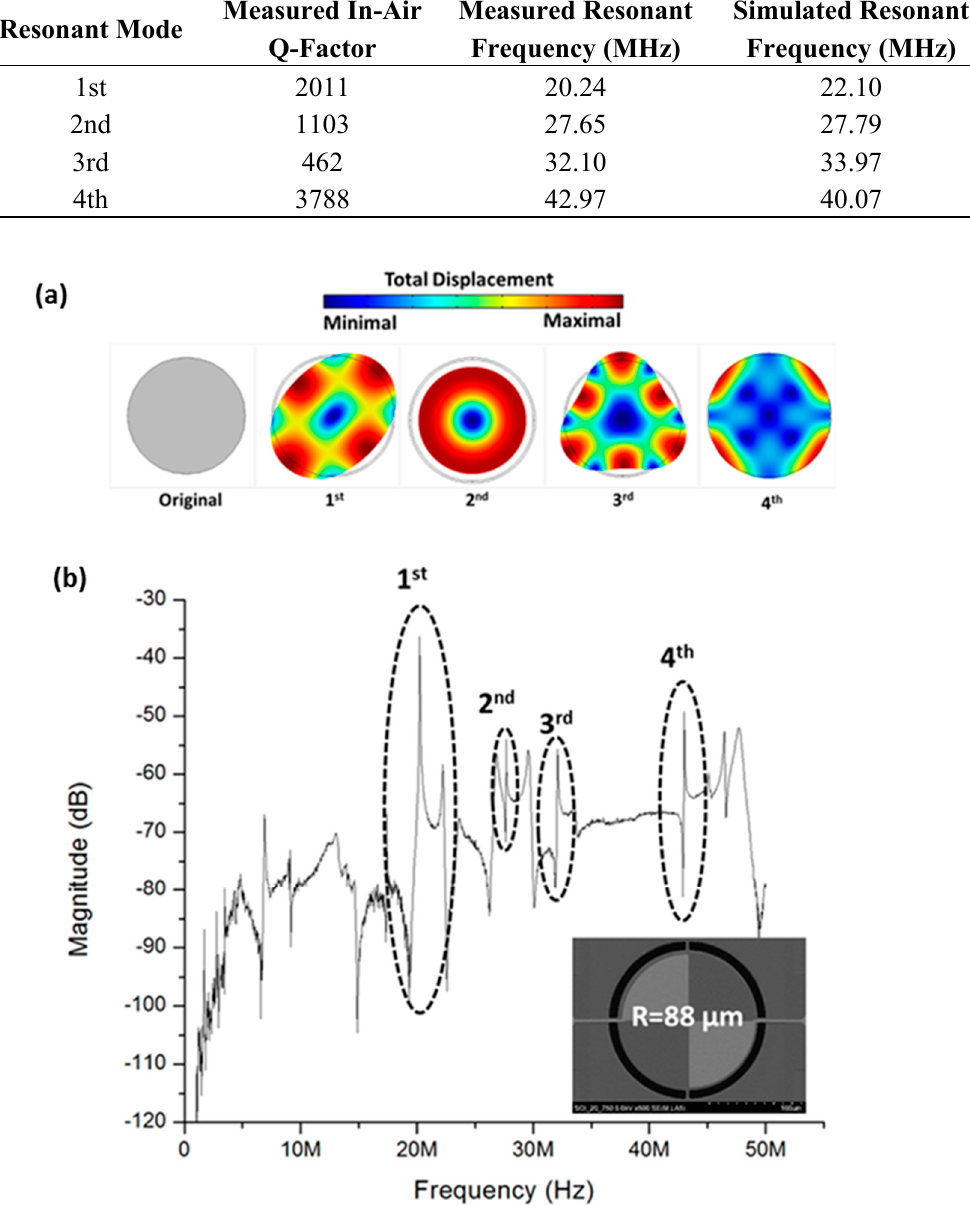
Table 2. Measured vs. simulated resonant characteristics of the first four contour modes of a 88 µm-radius disk resonator device.